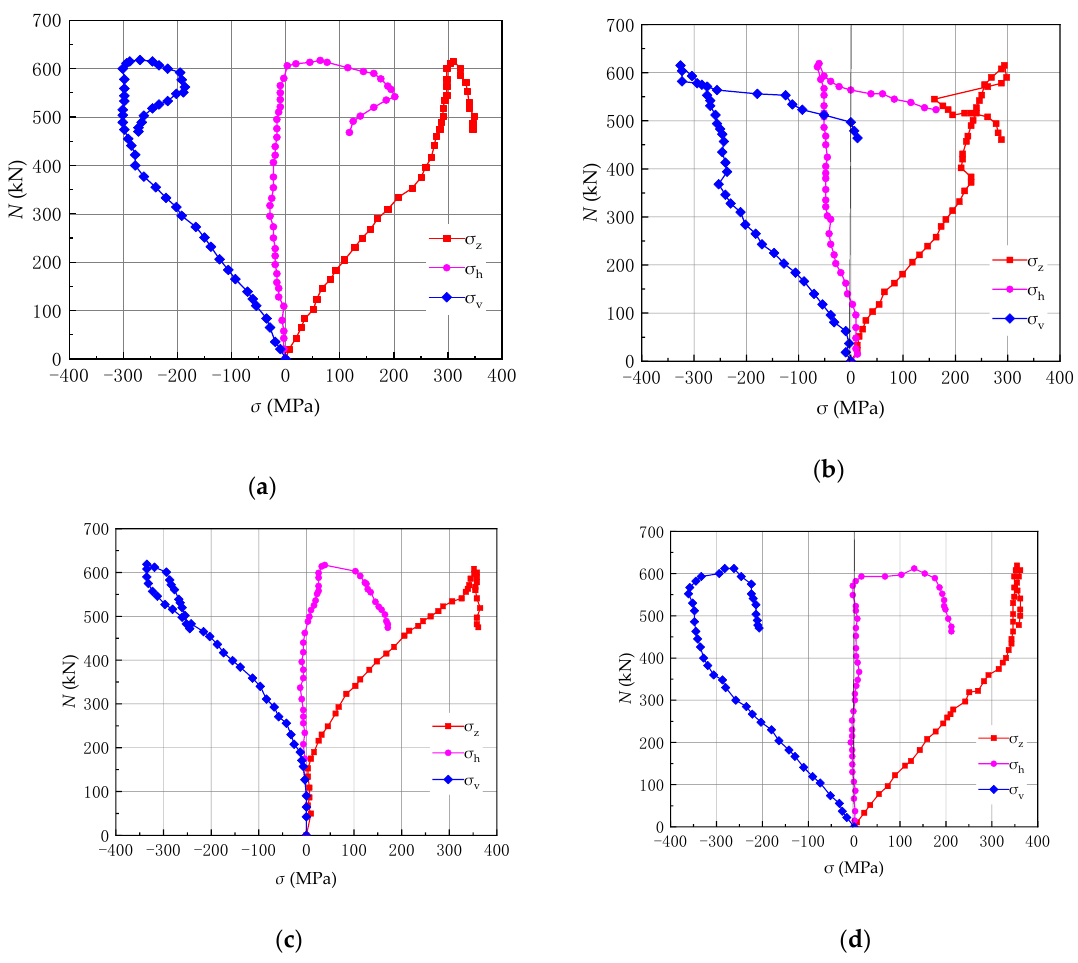
Figure 8. Load–stress curve of ( a ) measuring point on “1–1” surface; ( b ) measuring point on “2–3” surface; ( c ) measuring point on “3–2” surface; ( d ) measuring point on “4–3” surface.